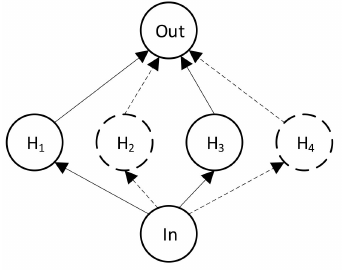
Figure 4. An example of dropout when p =